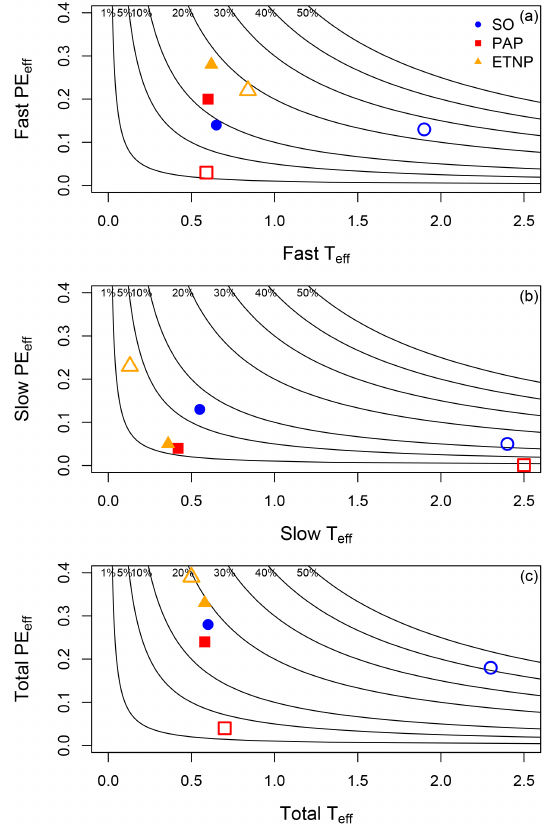
Figure 5. Efficiency of the biological carbon pump for (a) fast, (b) slow and (c) total sinking particles. Particle export efficiency (PE eff ) is plotted against transfer efficiency ( T eff ). Contours repre- sent BCP eff (proportion of primary production reaching depths of 150–300m). Blue circles are Southern Ocean, red squares PAP and orange triangles equatorial Pacific. Filled points show model output and open points are